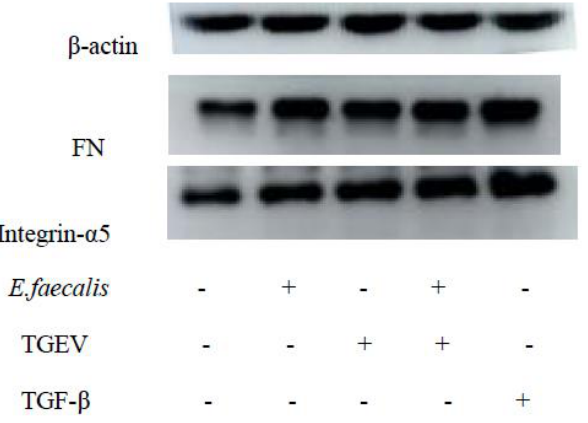
Figure 11. Western blot of E. faecalis receptors under different conditions. The first and the fifth groups are the negative and positive control